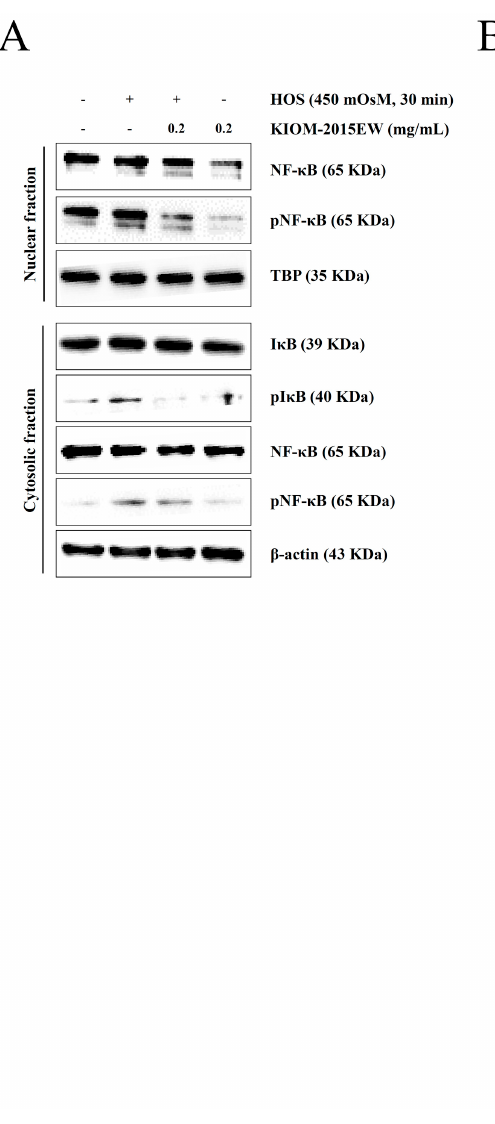
Figure 6. Effects of KIOM-2015EW on the nuclear translocation of NF- κ B and phosphorylation of I κ B- α in HOS-induced HCECs. ( A ) HCECs were simultaneously exposed to HOS and treated with 0.2 mg/mL KIOM-2015EW for 5 min. Cytosolic proteins were subjected to western blot analysis with the indicated antibodies. β -Actin was used as the internal control for the cytosolic fraction. The numbers represent the average densitometric values relative to β -actin. Data are summarized as mean ± SD from three independent experiments; ( B ) NF- κ B p65 activation was examined by immunofluorescence staining. Scale bar, 100 µ m. The full size blot is shown in Supplementary Figure